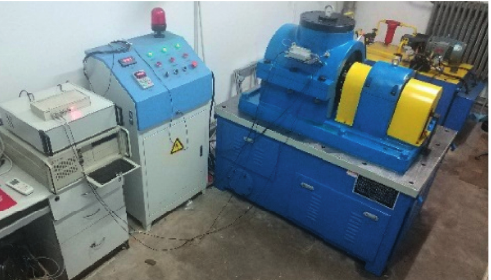
Figure 2: Bearing test and information collection system of the metro traction motor.